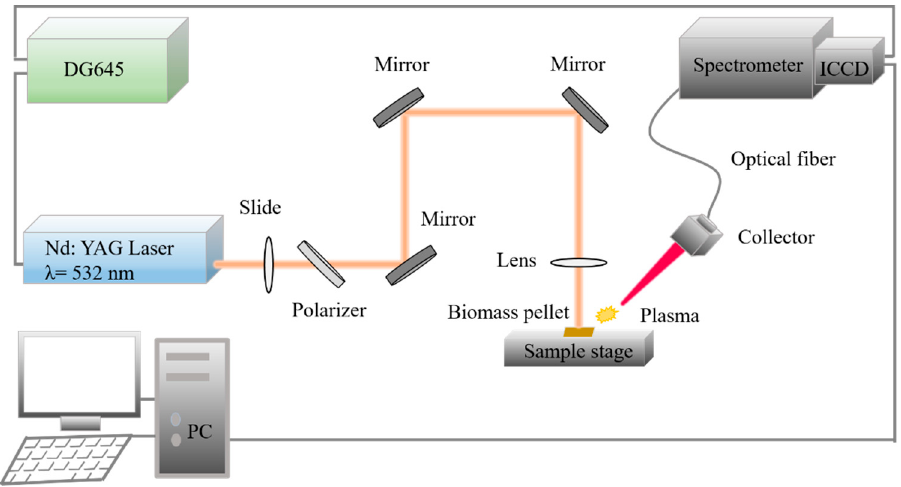
Figure 1. Schematic diagram of the LIBS system.